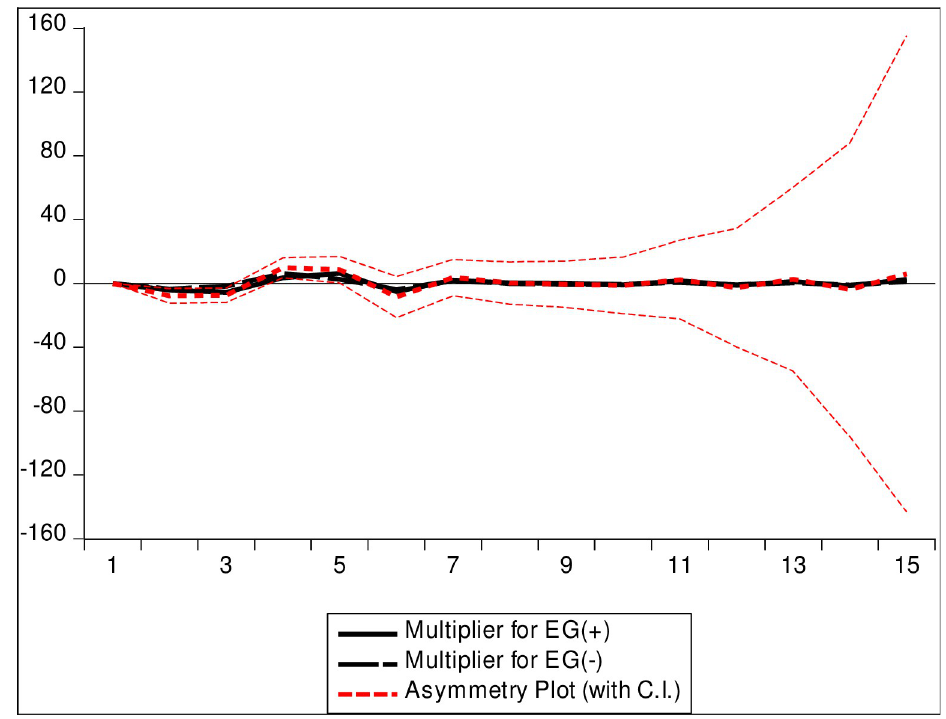
Fig 2. Multiplier graph for EG(Pos) and